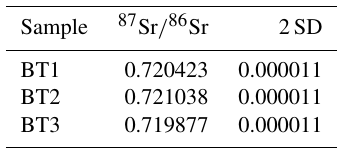
Table 1. 87 Sr / 86 Sr from aliquots of the Barstow tufa run by thermal ionization mass